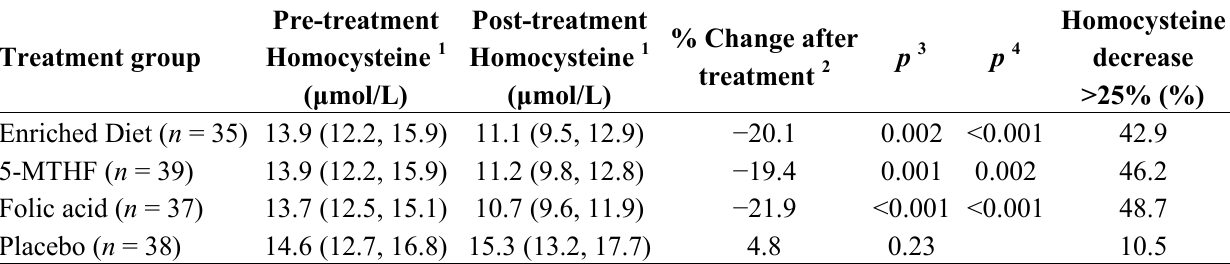
Table 3. Distribution of Hcy levels before and after the intervention according to treatment